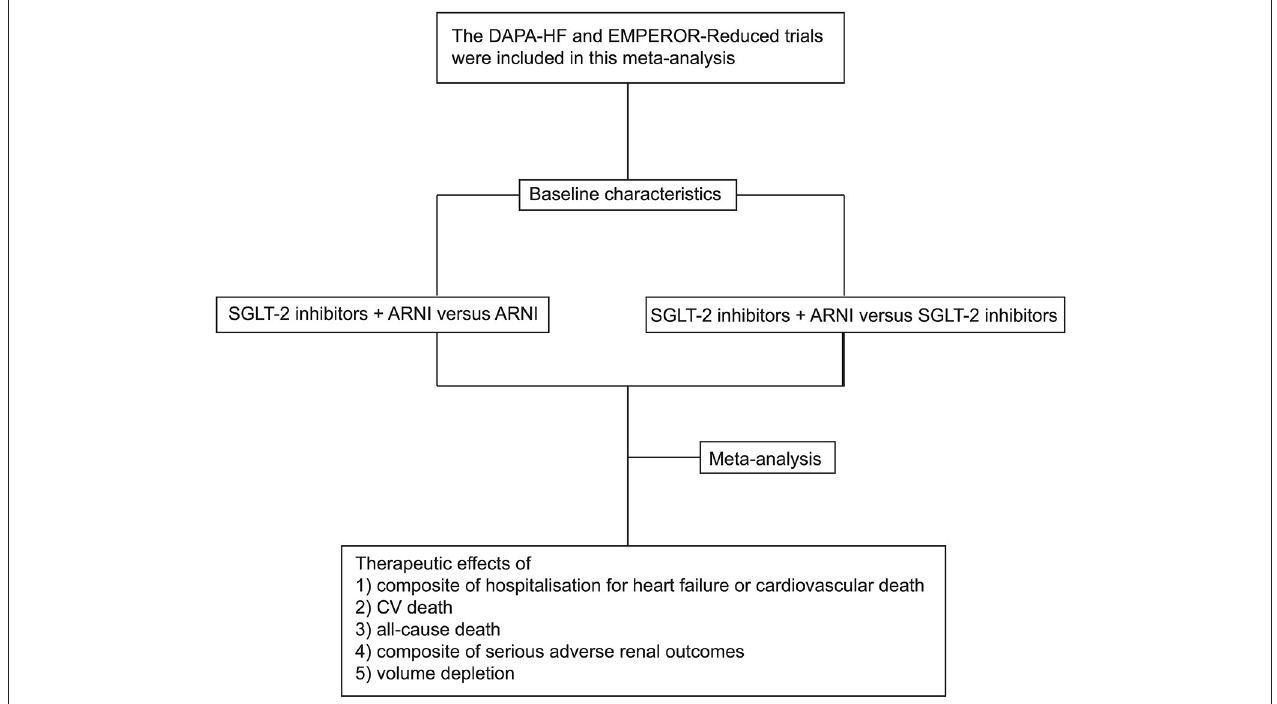
FIGURE 1 | The flow chart of the